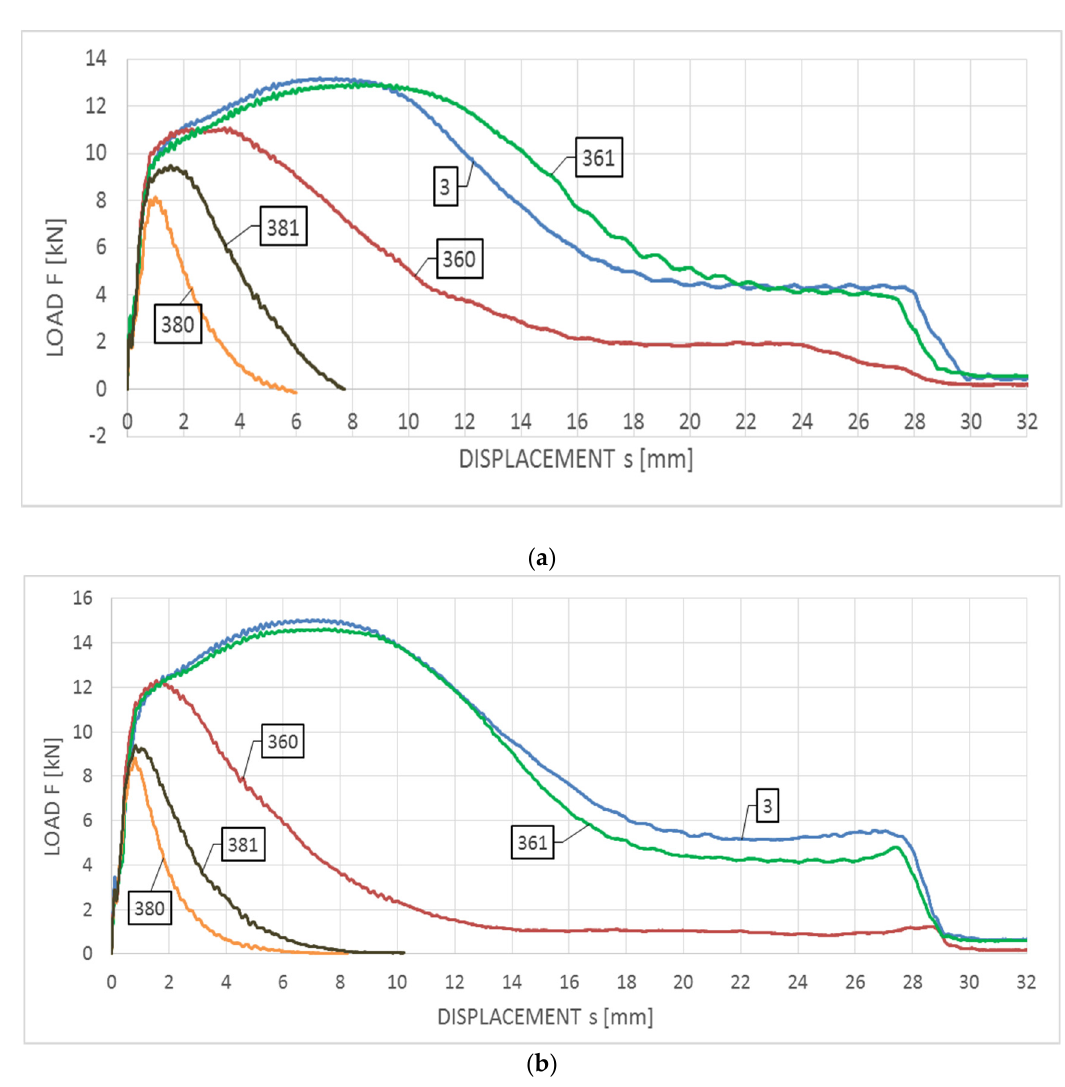
Figure 12. Averaged 𝐹 − 𝑠 curves obtained on the samples made of X2CrNiMoN22-5-3 steel: ( a ) during tests conducted in +20 °C, ( b ) during tests conducted in − 20 °C.